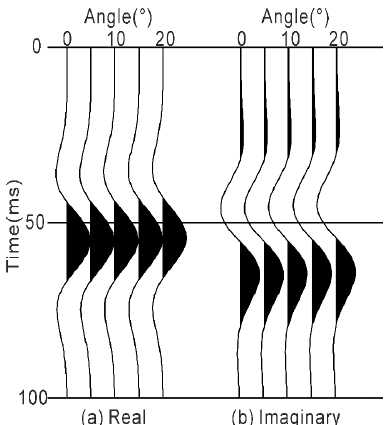
Figure 5. Complex seismic traces of Model 3: ( a ) real component; ( b ) imaginary component.